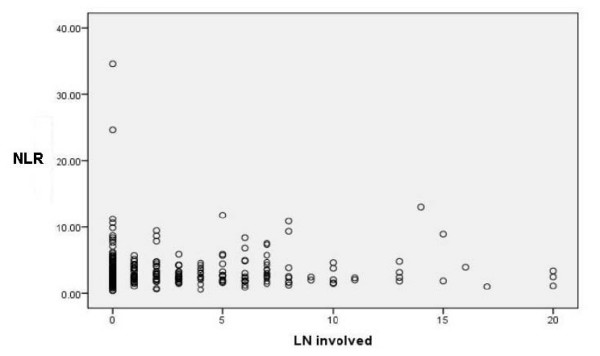
NLR and ratio of involved to total lymph node yields.